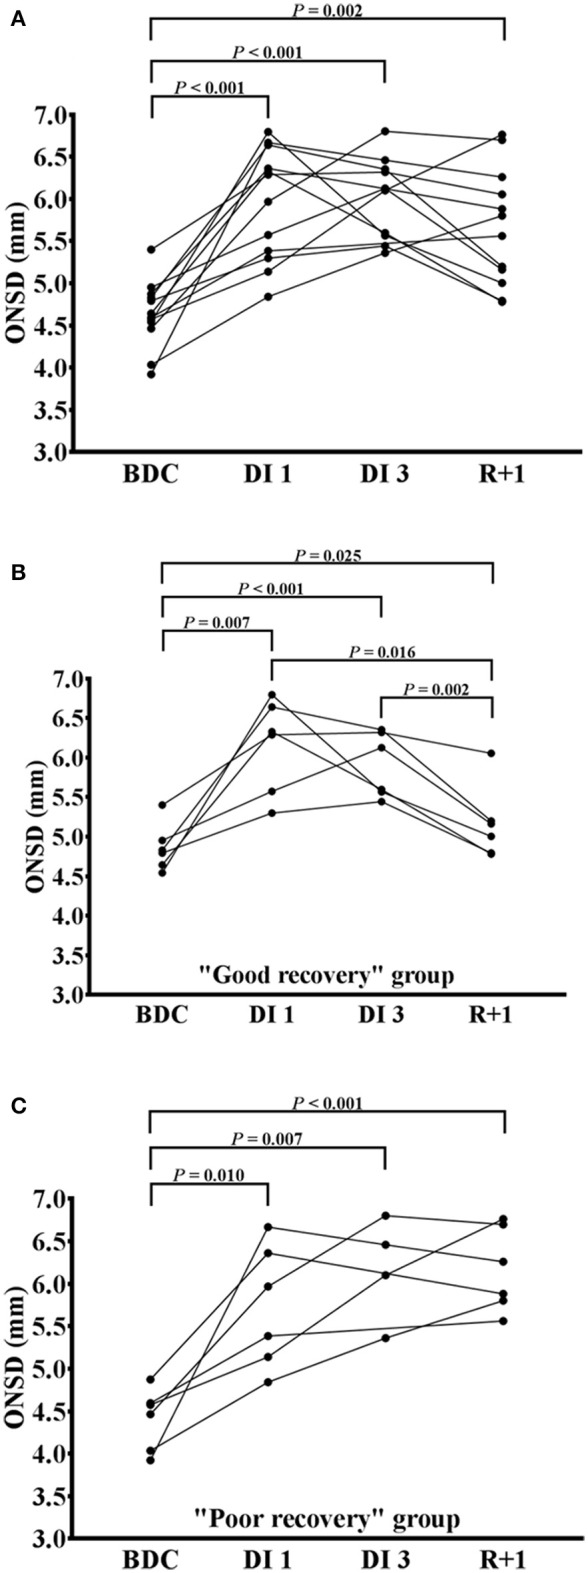
Changes in optic nerve sheath diameter after dry immersion. Changes in optic nerve sheath diameter (ONSD) before (BDC), the first day (DI 1), the third day (DI 3) and after (R+1) dry immersion in all subjects (A), “good recovery” group (B) and “poor recovery” group (C). Individuals points with the changing curves are represented. P < 0.05 vs. BDC; P < 0.01 vs. BDC; P < 0.001 vs. BDC.